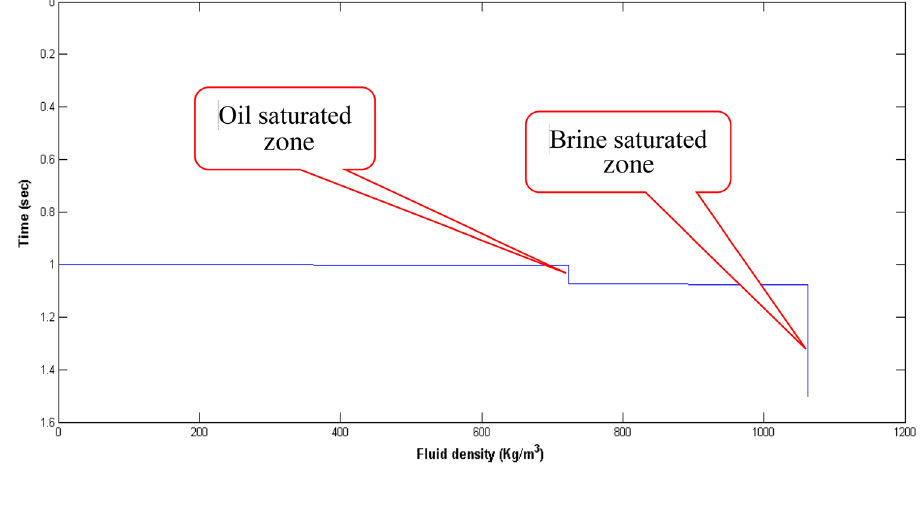
Fig. 14 Fluid velocity plot with 20% porosity of Arab